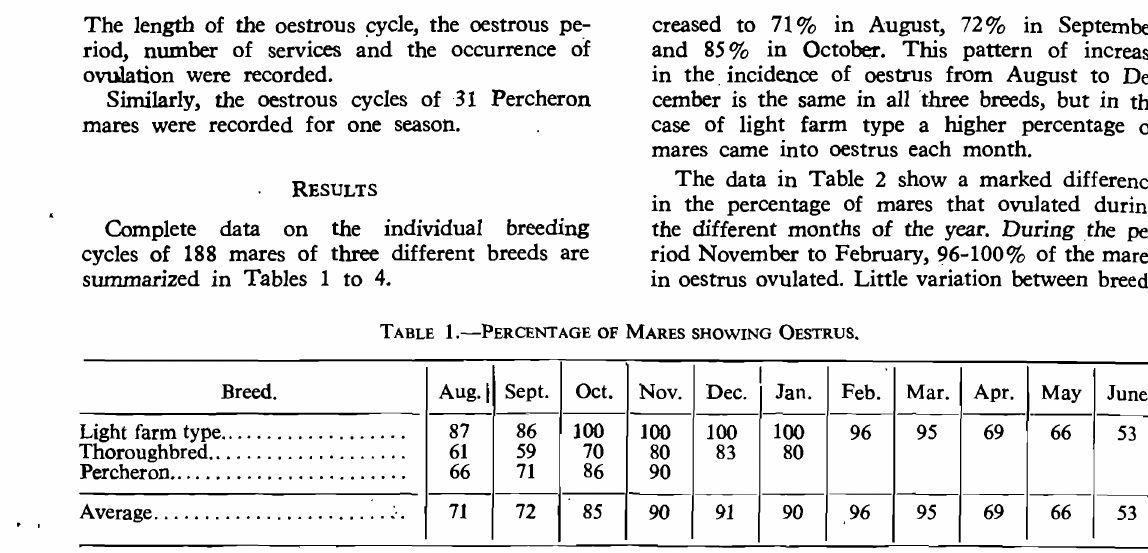
The average percentage of .a11 mares showing signs of oestrus during the different months of the year is given in Table 1. Except for July, when no observations were recorded, mares came into oestrus right through the year. The percent age of the available mares which came into oestrus was fairly constant for the months October to March, with an average range of 85-95 % of mares in oestrus in all three breeds under ob servation. The average for the Thoroughbred mares was about 10% lower than for the Per cheron and 20% lower than for the light farm type mares for the same period. The percentage of mares on heat showed an appreciable decline from 95% in March to: 53% in June, but in-